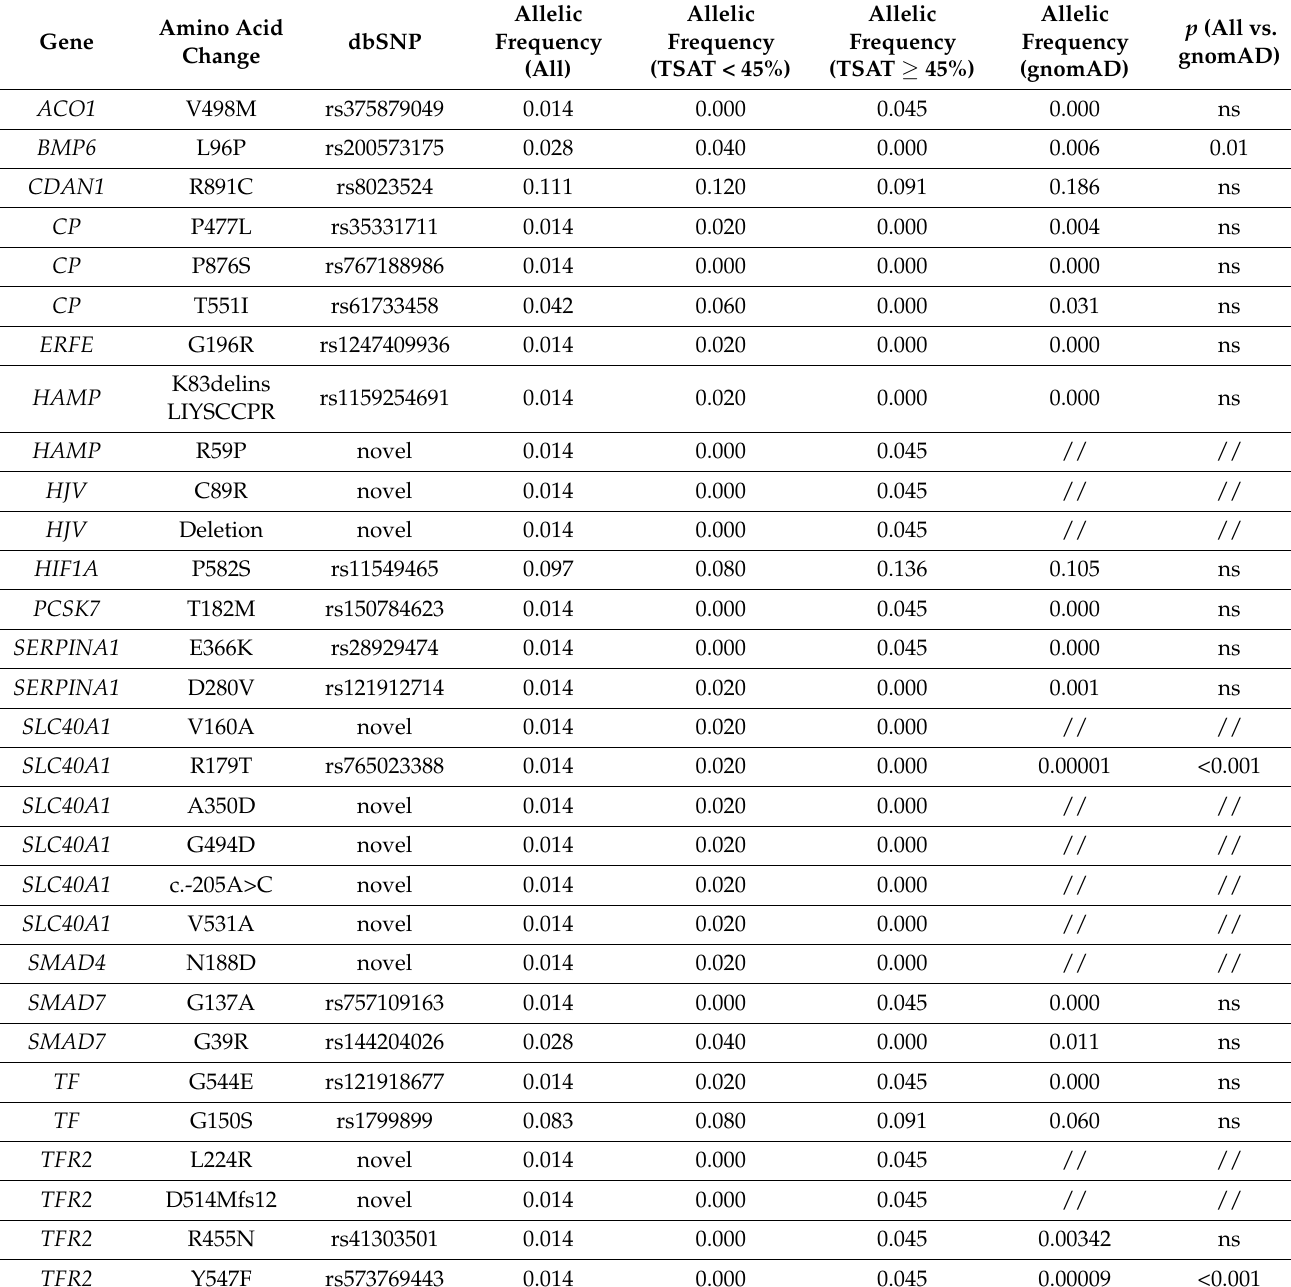
Table 1. List of 30 variants (including novel mutations) and their allelic frequencies found in the whole 36 patients, and in subgroups according to transferrin saturation (TSAT) compared to gnomAD